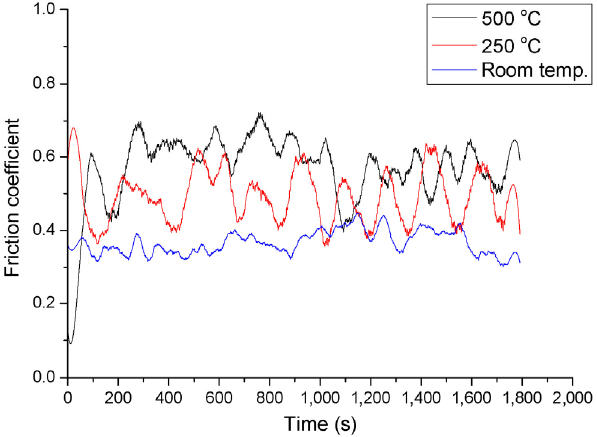
Fig. 8 Coefficient of friction of the CoCrFeNiTi 0.5 Al 0.5 alloy as a function of sliding time at different temperatures.